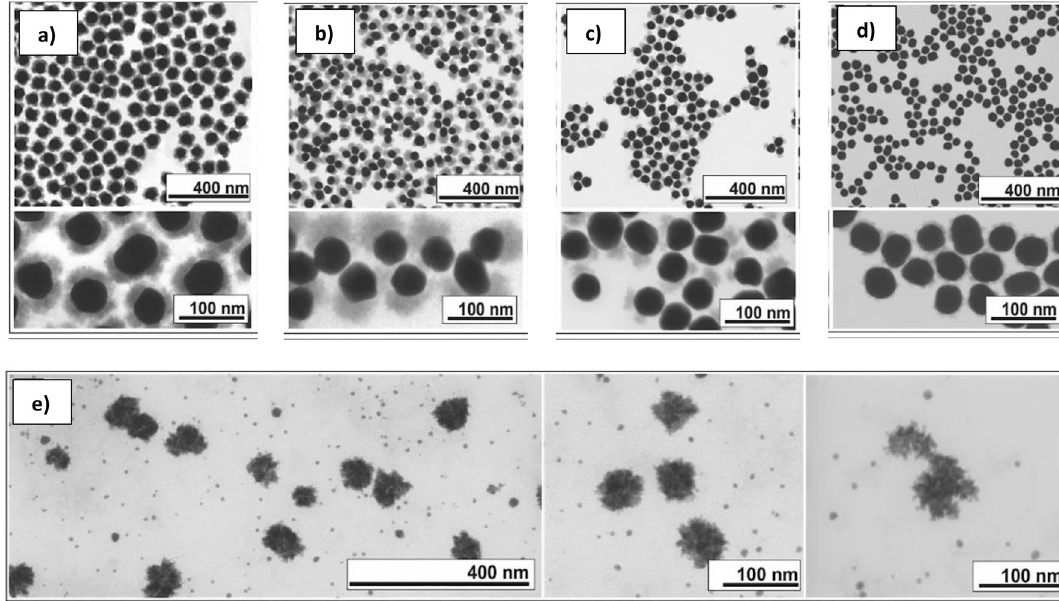
Figure 4. TEM images of Au NCs at different MUA molecules to Au surface ratios. ( a ) 0, ( b ) 0.5, ( c ) 50, ( d ) 500 and ( e )